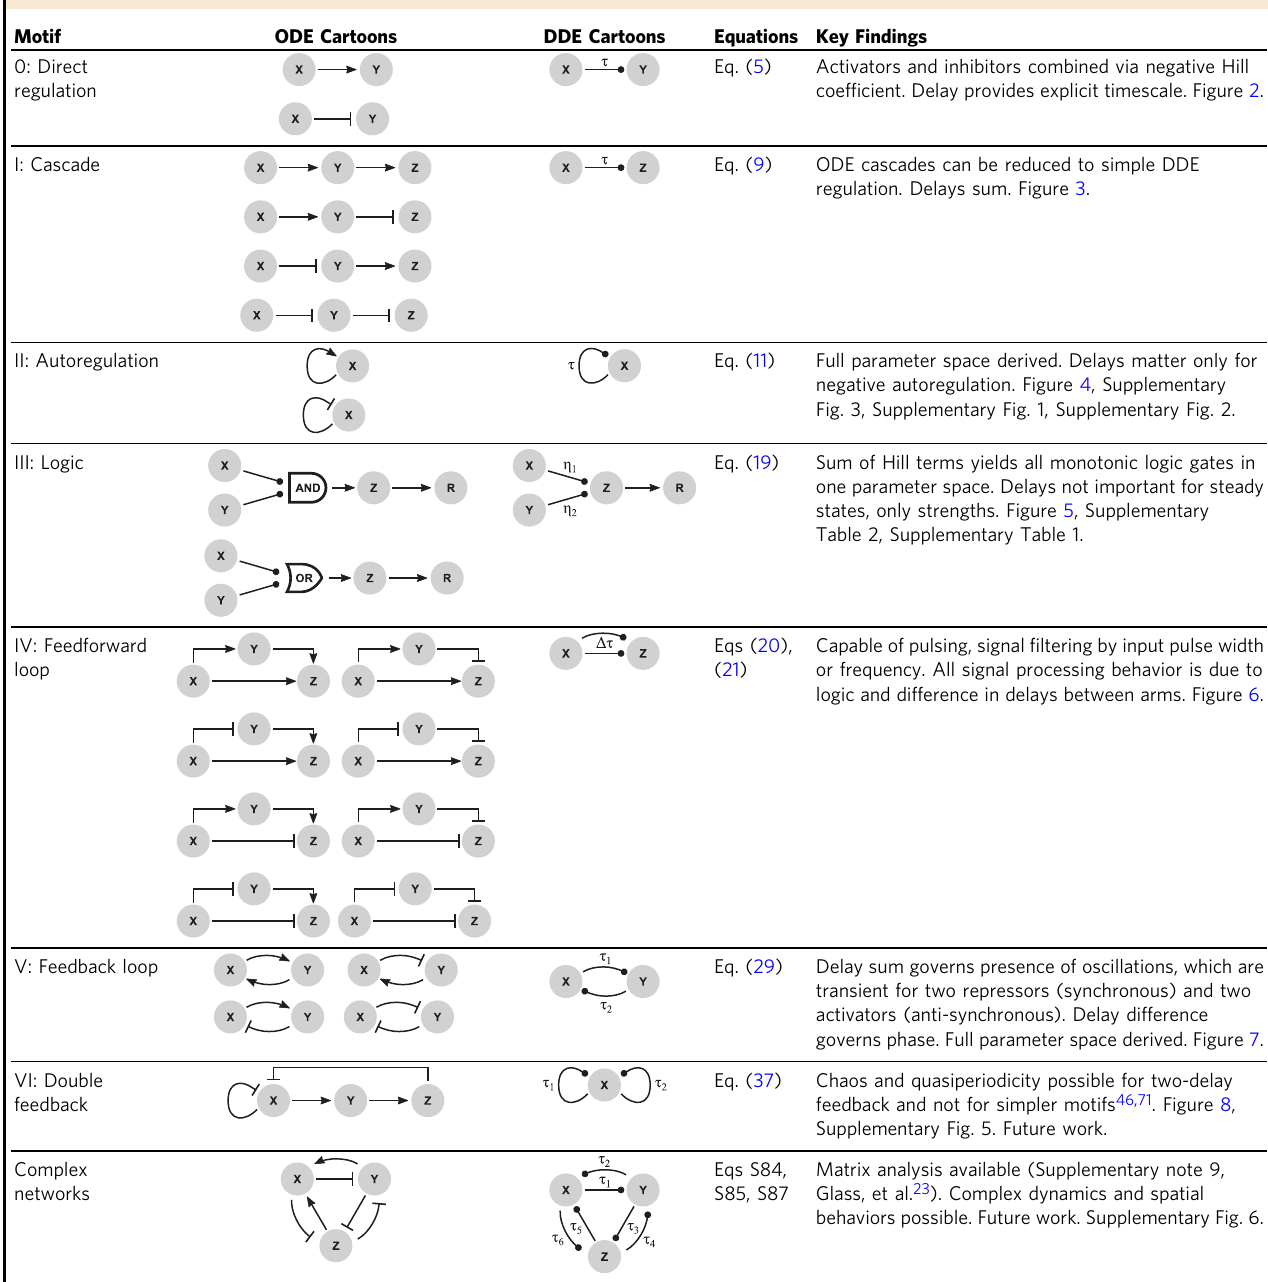
Table 2 Summary of differences between ODE and DDE network regulation models and key fi ndings, and where each DDE cartoon provides a simpli fi ed, uni fi ed model for several ODE cartoons.